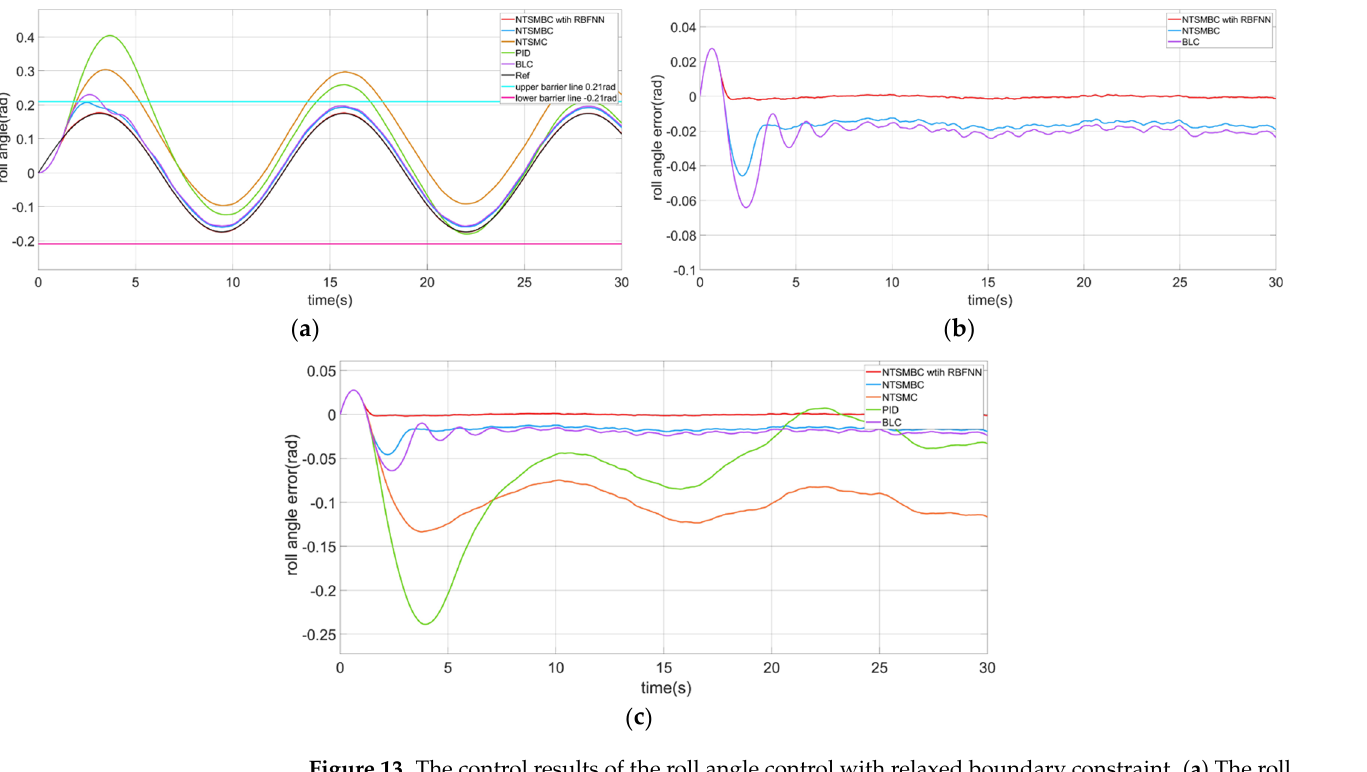
Figure 13. The control results of the roll angle control with relaxed boundary constraint. ( a ) The roll angle control results of the four control methods with relaxed boundary constraints. ( b ) The roll angle control error with relaxed boundary constraints. ( c ) Local magnification.